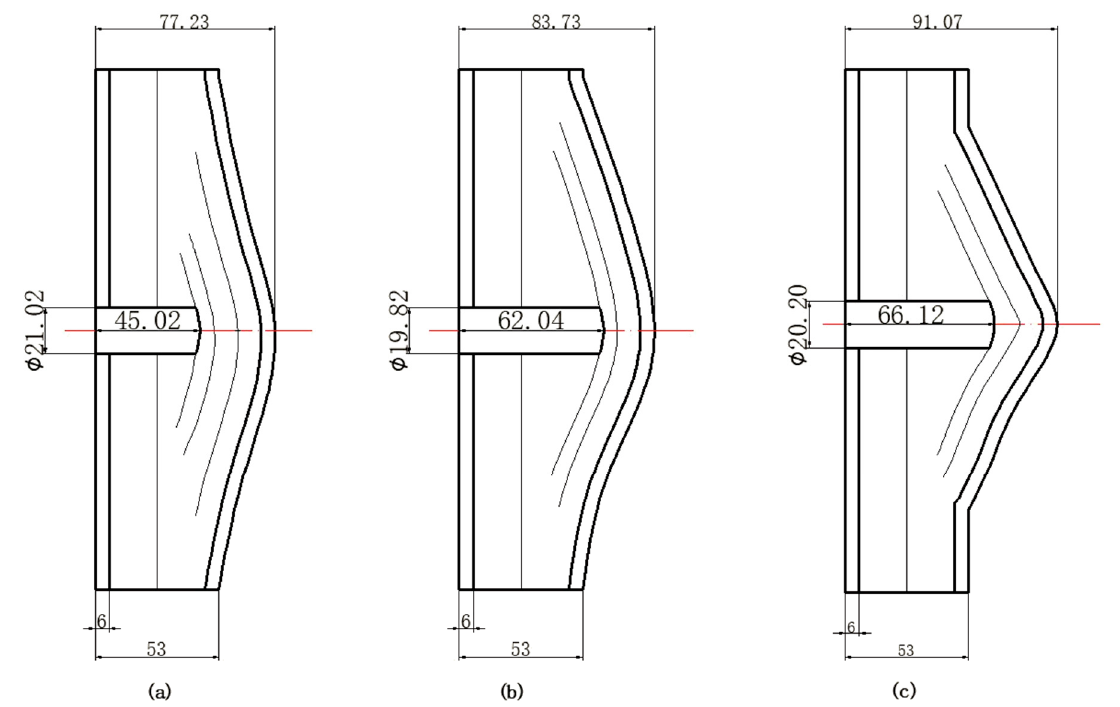
Figure 9. Deformation and perforation profiles of armor with two layers of PE (unit: mm). ( a ) v = 759 m/s. ( b ) v = 1139 m/s. ( c ) v = 1174 m/s.